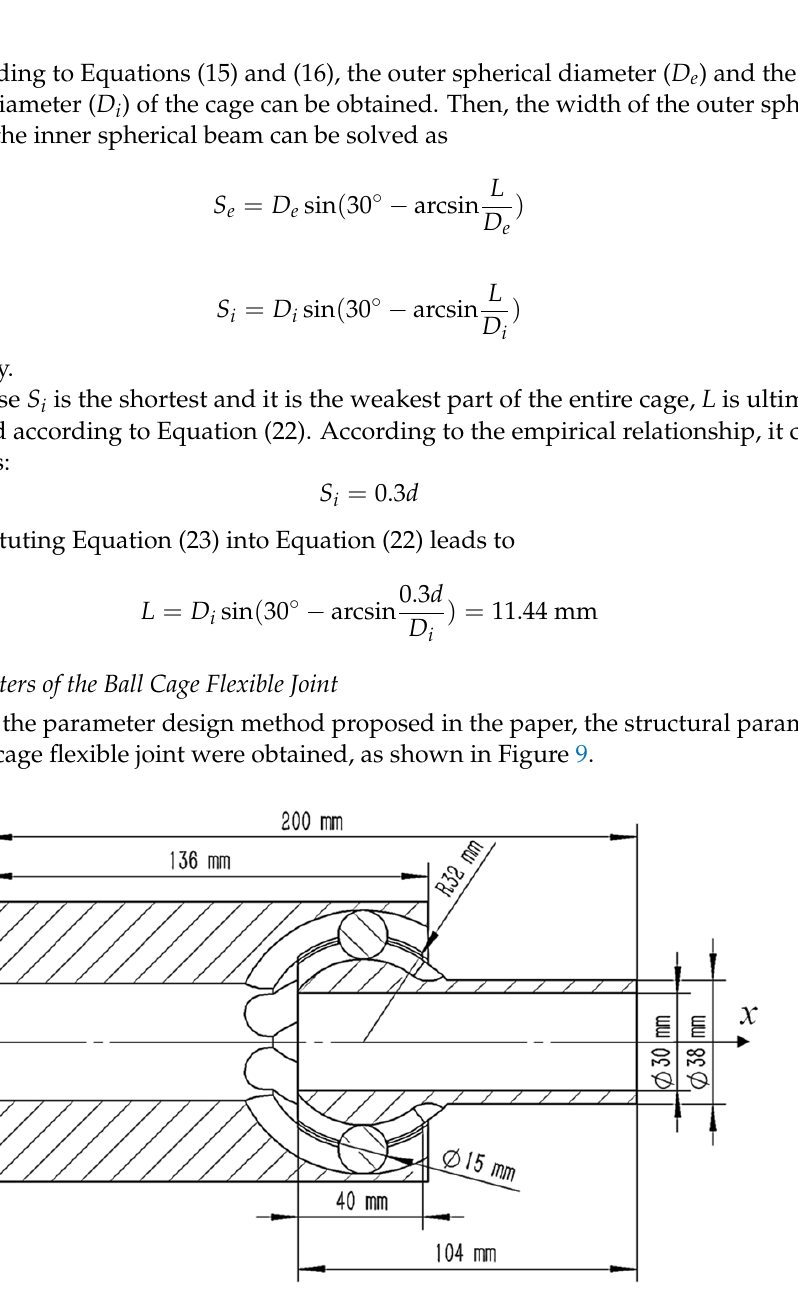
Figure 10. Multi-body dynamics model of flexible joint.